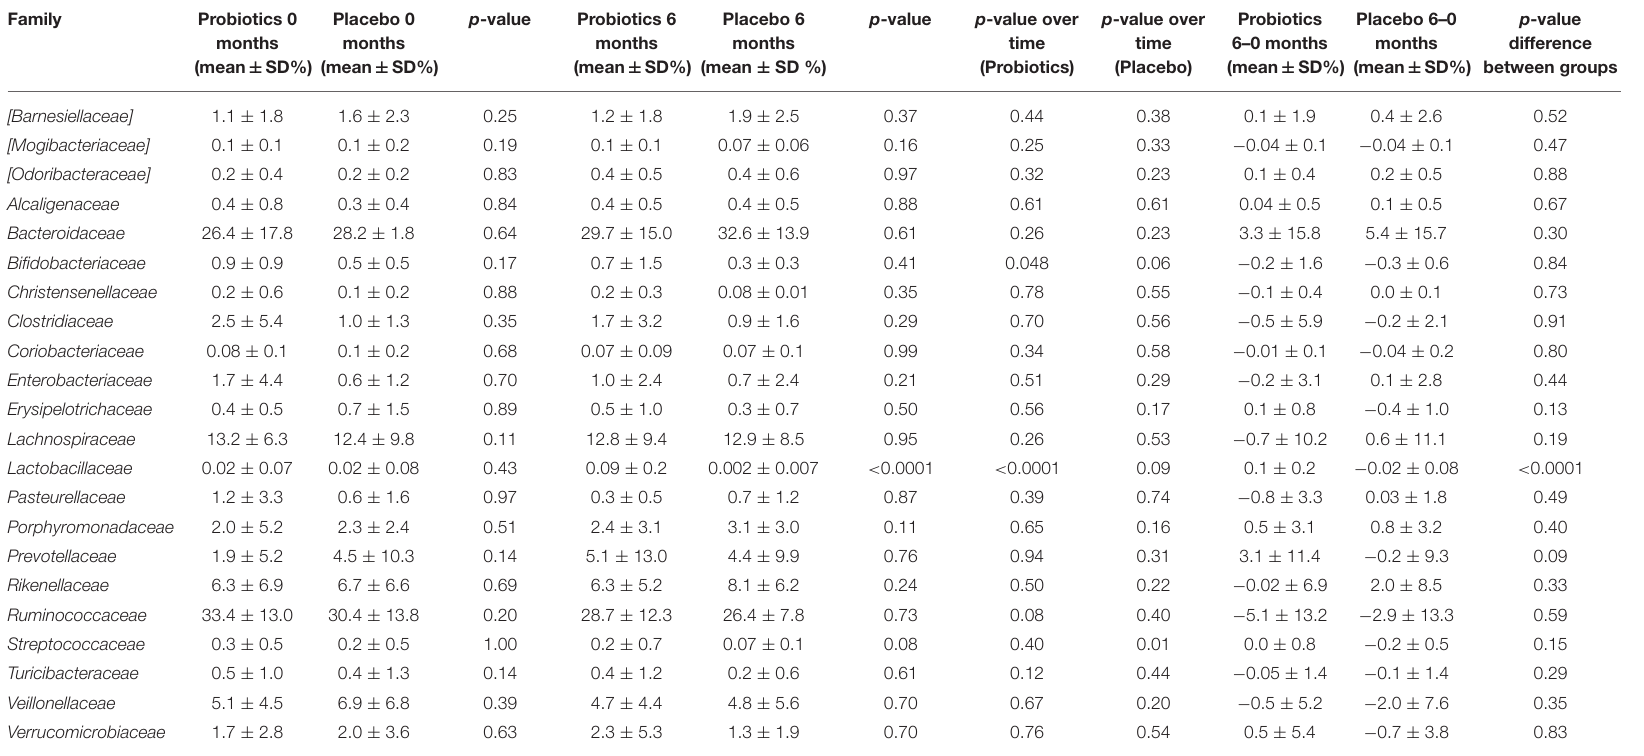
TABLE 2 | Relative abundance of different families in study participants either receiving a mixture of L. plantarum HEAL9 and L. paracasei 8700:2 (Probiotics) or maltodextrin (Placebo) at baseline and after 6 months of intervention.